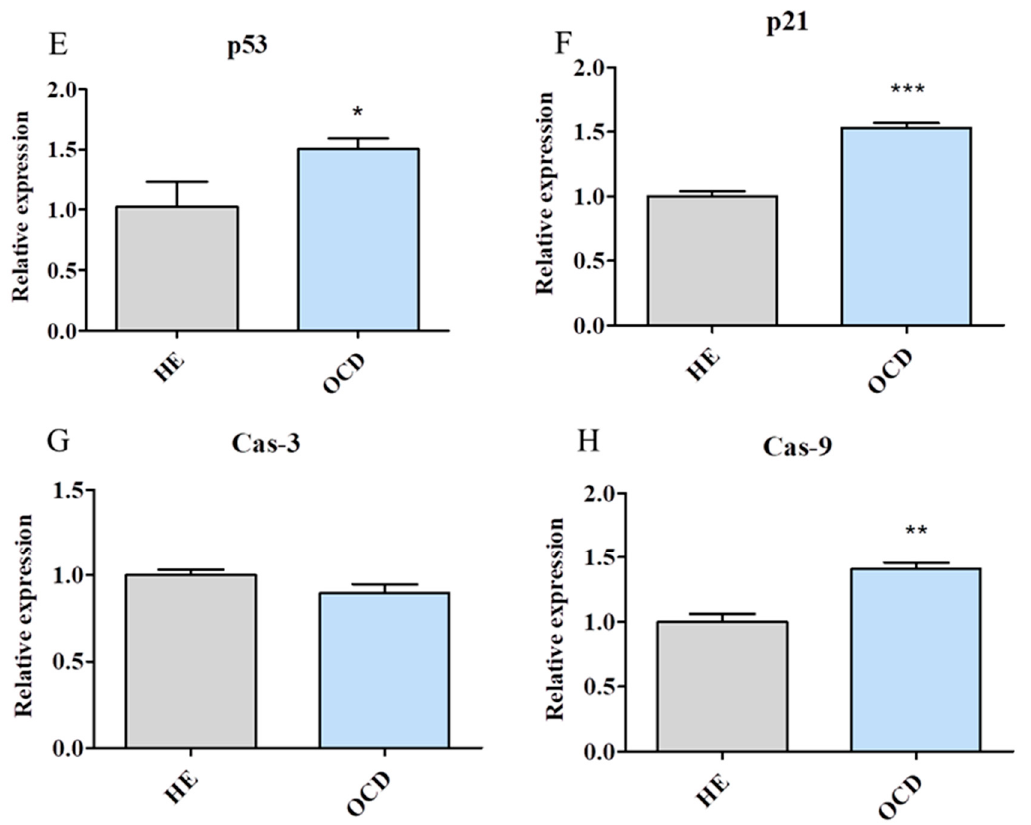
Figure 3. Evaluation of senescence and apoptosis. Live chondrocytes were stained with Calcein A.M ( A ) while nuclei of dead cells with propidium iodide (indicated with white arrows, B ). Cells were observed under epi-fluorescent microscope. Moreover accumulation of senescence-associated β -galactosidase was visualized (indicated with yellow arrows, C ) and imaged using wide field inverted microscope. Apoptotic status of chondrocytes based on caspase-3/7 activation, cellular plasma membrane permeabilization and death was established using the MUSE Cell Analyzer ( D ). In addition expression of apoptotic-related genes eg. p53 ( E ), p21 ( F ), cas-3 ( G ) and cas-9 ( H ) was evaluated using RT-PCR. Scale bars: epifluorescent: A-250 µ m, B-100 µ m, brightfield-150 µ m. Results expressed as mean ± S.D. * p < 0.05, ** p < 0.01, *** p < 0.001.